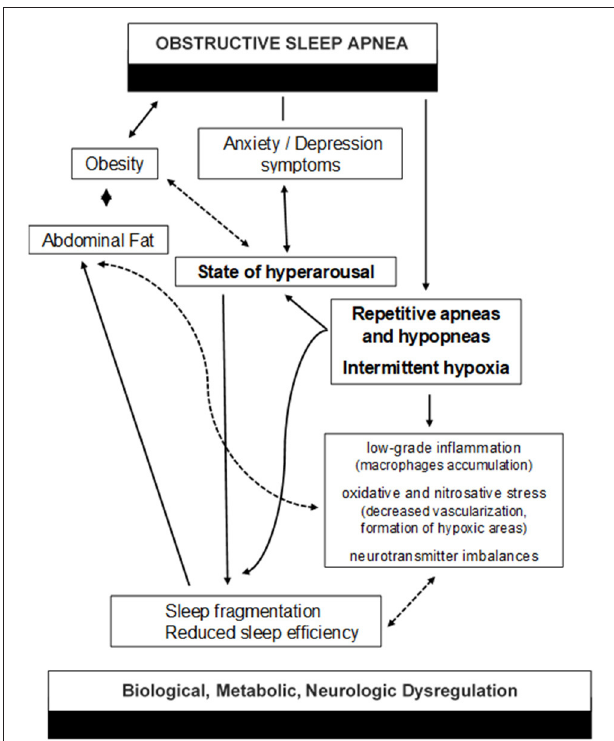
FIGURE 1 | The vicious cycle between biological, metabolic, and neurologic dysregulation in OSA.